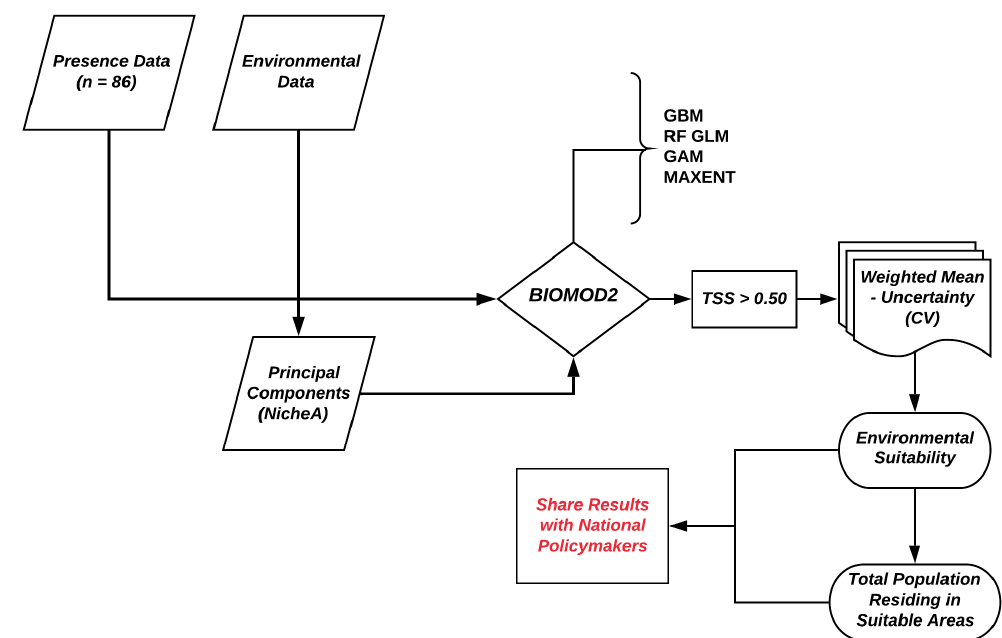
Figure 3. Workflow for tungiasis environmental suitability mapping.